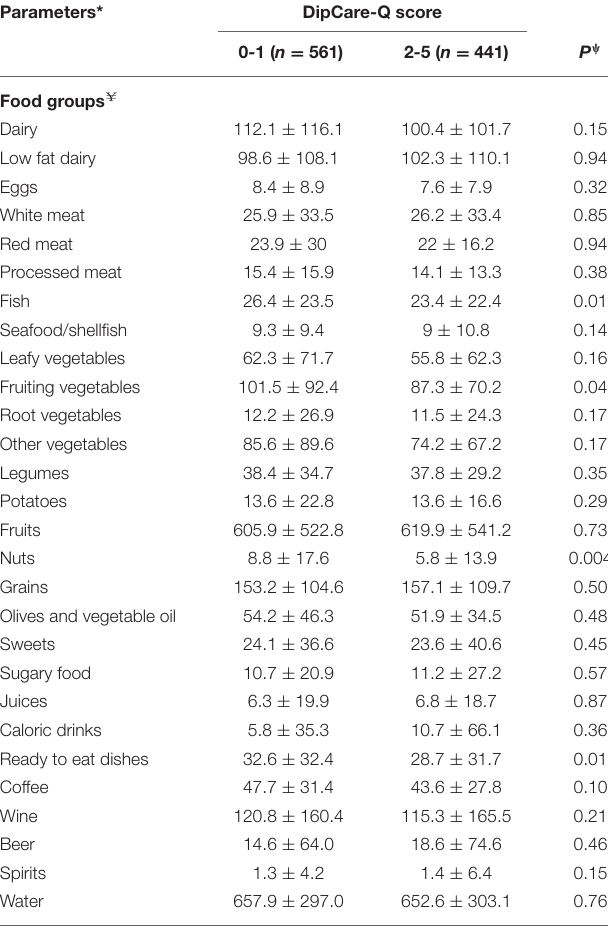
TABLE 1 | Sociodemographic and clinical variables of the study population categorized according to the Deprivation in the Primary Care Questionnaire (DiPCare-Q) score.